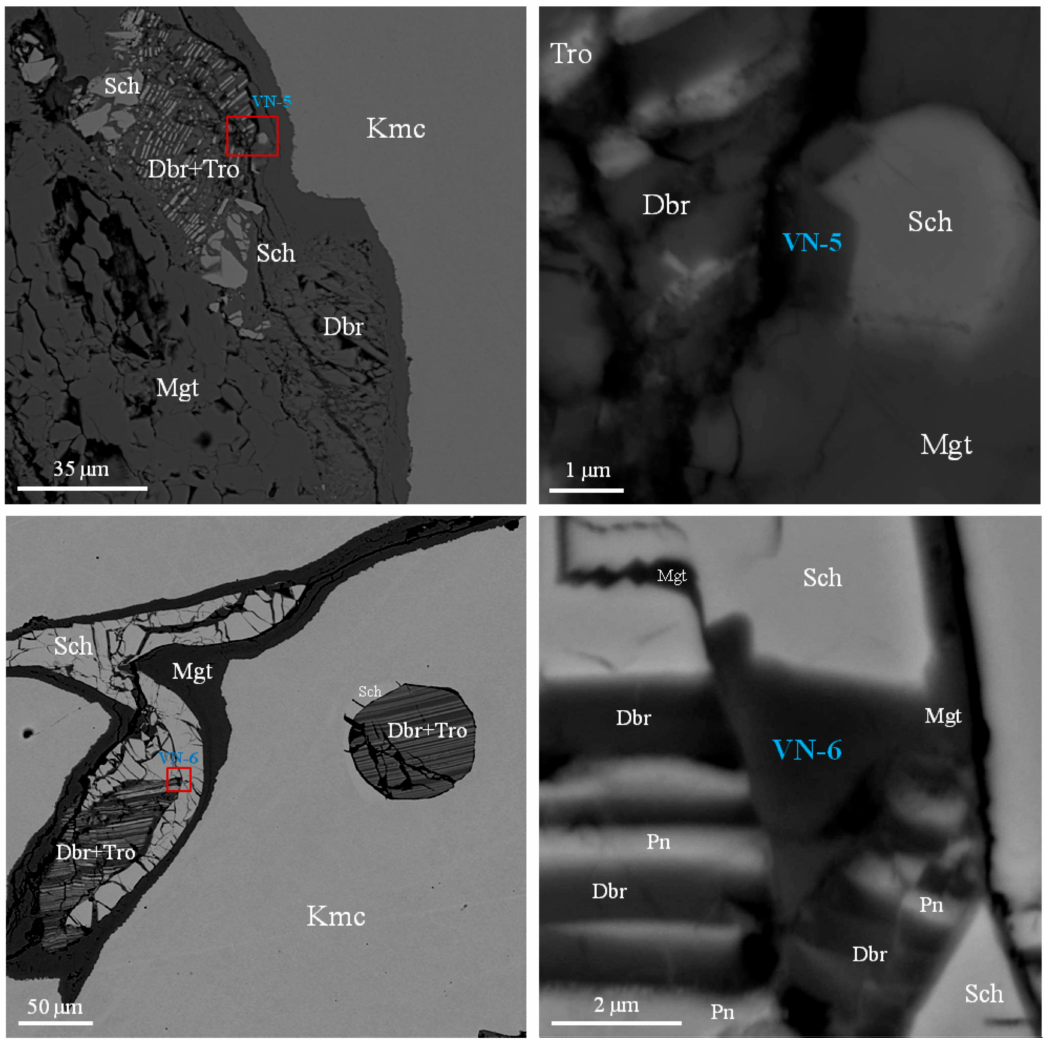
Figure 6. Uakitite in resorbed troilite–daubr é elite–schreibersite globules from fissures filled with magnetite, Uakit meteorite (IIAB), BSE images. Symbols: VN-5, VN-6—uakitite; Dbr—daubr é elite; Tro—troilite; Sch—schreibersite; Mgt—magnetite;